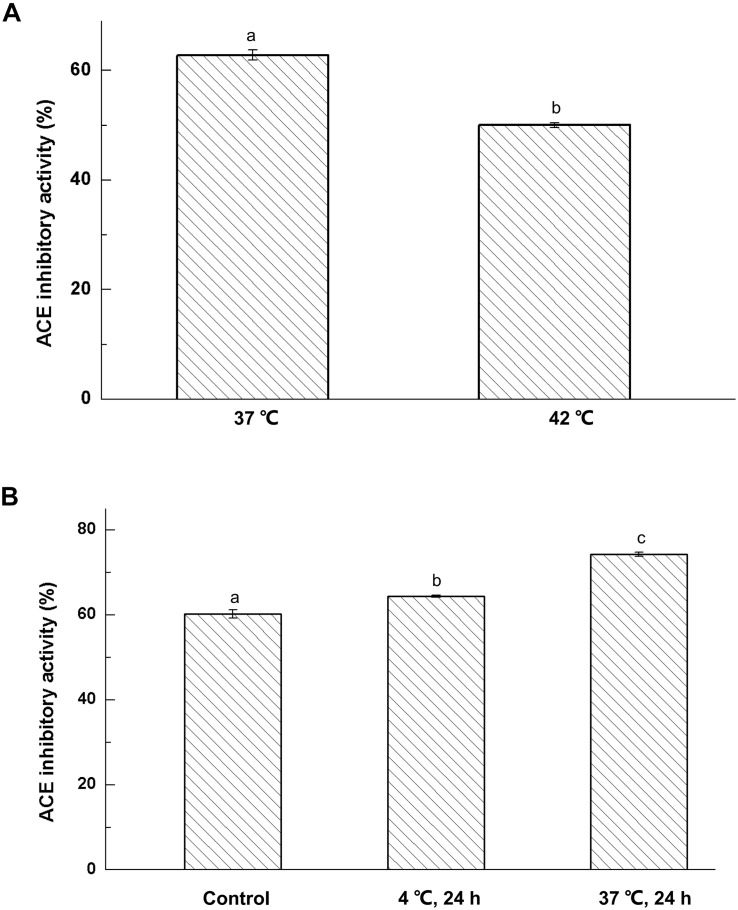
Effect of fermentation temperature (A) and storage conditions (B) on ACE-inhibitory activity of fermented milk; The column data with different letters means significant difference (α = 0.05).